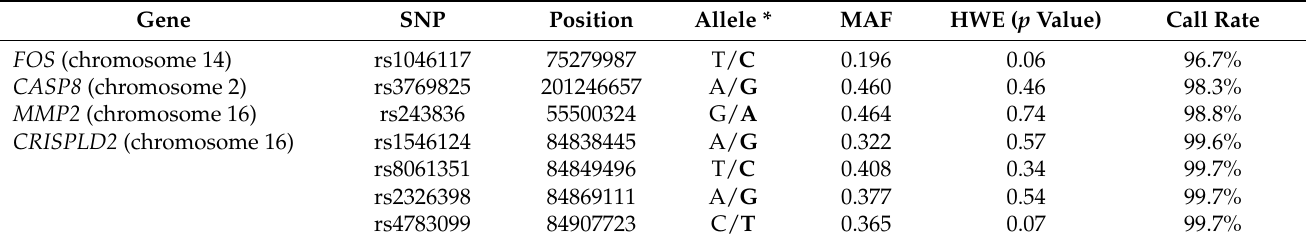
rs243836 55500324 G/